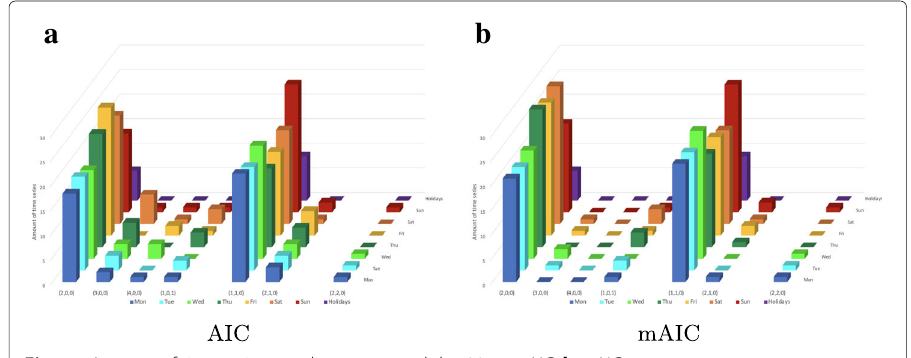
Fig. 11 Amount of time series per cluster per weekday 2017. a AIC. b mAIC